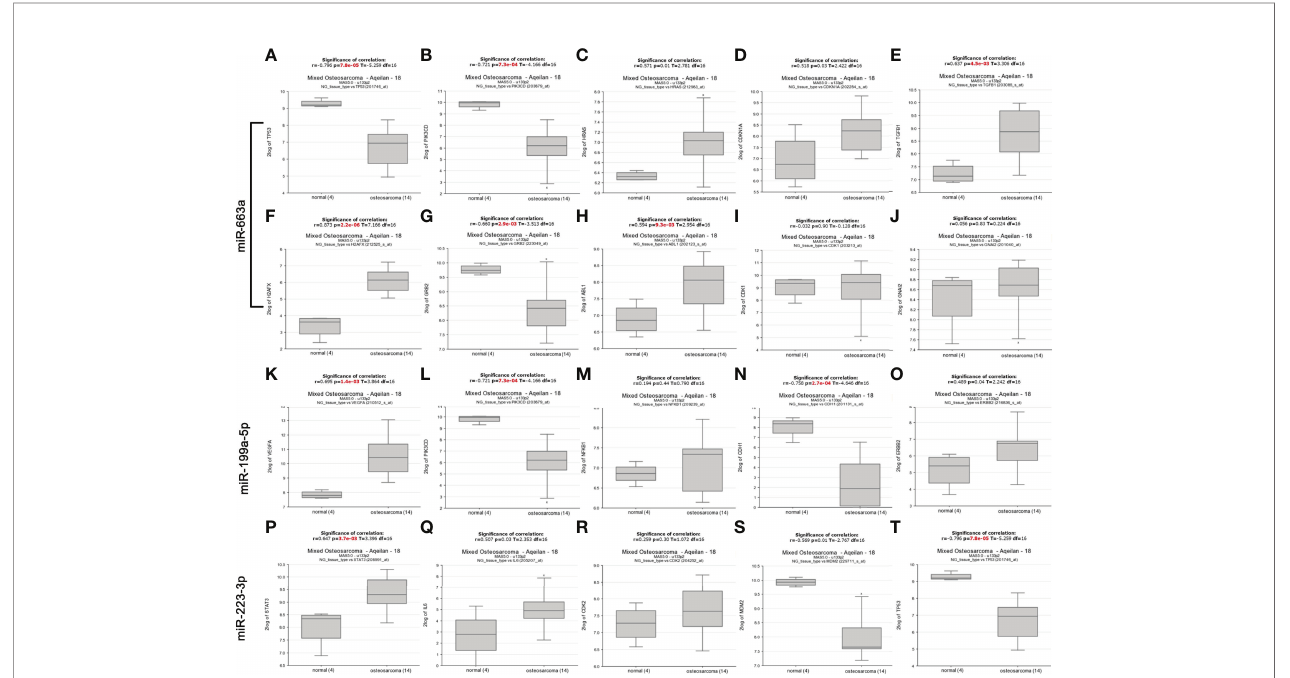
FIGURE 2 | The mRNA expression of predicted targets of miR-663a, miR-199a-5p and miR-223-3p from the R2 database (https://hgserver1.amc.nl/cgi-bin/r2/ main.cgi). (A) TP53 expression; (B) PIK3CD expression; (C) HRAS expression; (D) CDKN1A expression; (E) TGFB1 expression; (F) H2AFX expression; (G) GRB2 expression; (H) ABL1 expression; (I) CDK1 expression; (J) GNAI2 expression; (K) VEGFA expression; (L) PIK3CD expression; (M) NFKB1 expression; (N) CDH1 expression; (O) ERBB2 expression; (P) STAT3 expression; (Q) IL6 expression; (R) CDK2 expression; (S) MDM2 expression; (T) TP53 expression. The expression of HRAS, CDKN1A, TGFB1, H2AFX, ABL1, VEGFA, ERBB2, STAT3 and IL6 was signi fi cantly upregulated in osteosarcoma tissue compared with normal tissue whereas TP53, PIK3CD, GRB2, CDH1 and MDM2 were markedly downregulated.